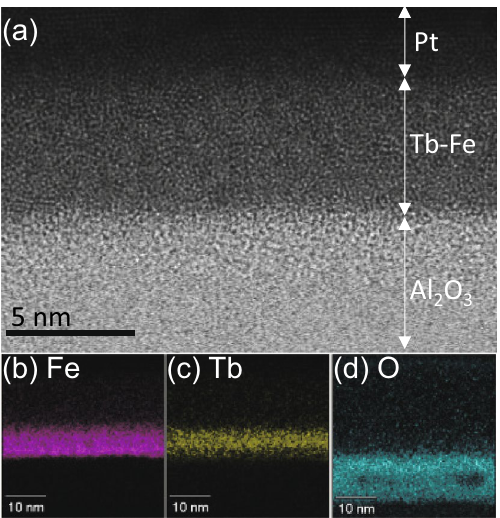
Figure 1. ( a ) Bright field scanning TEM image of our Tb–Fe sample taken before the strain application. Atomic distribution of ( b ) Fe, ( c ) Tb and ( d ) O obtained by EDS.